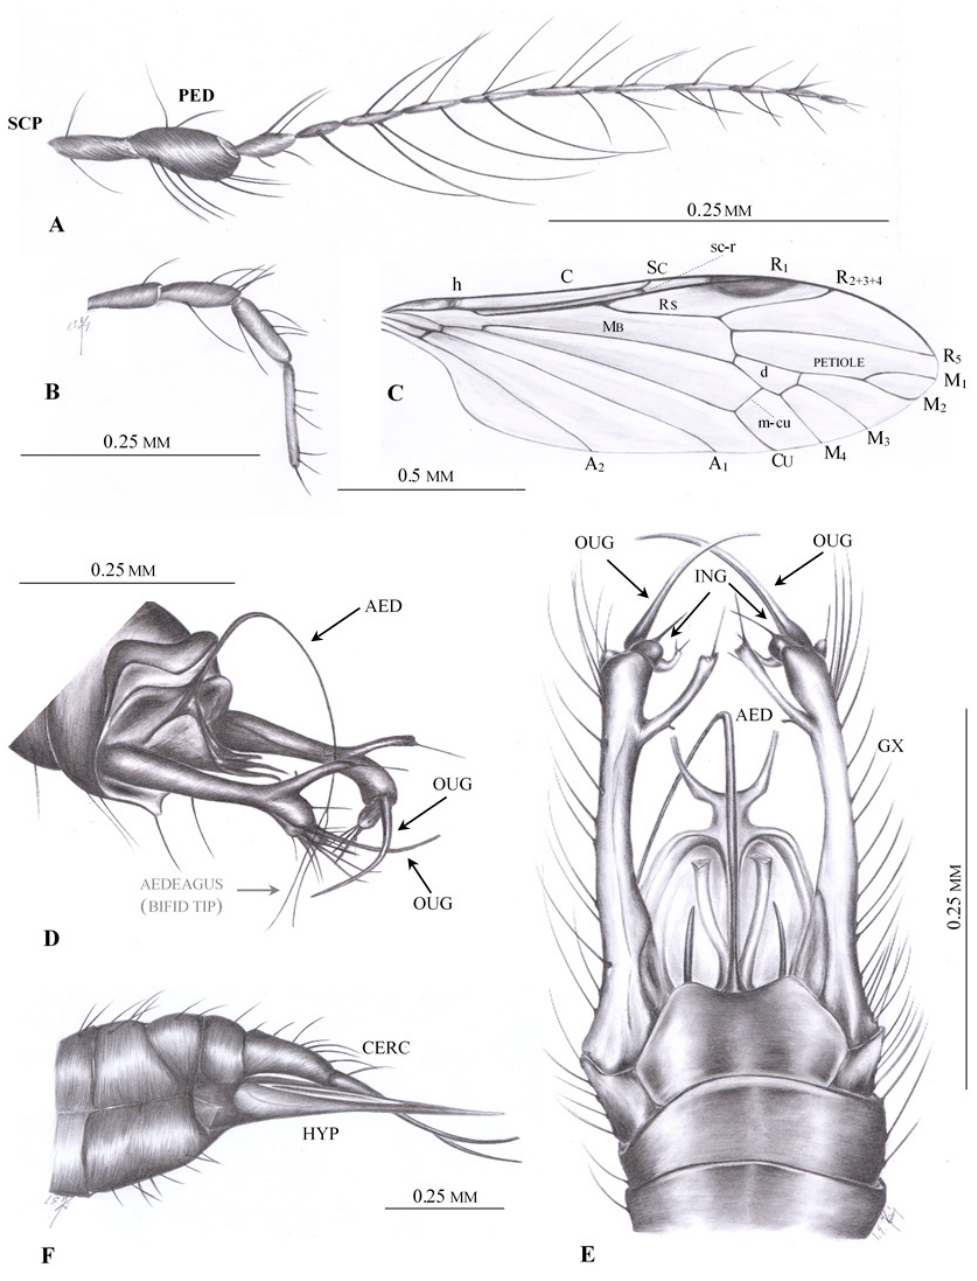
Figure 2. Drinosa prisca Podenas et Poinar, 2009 [13]. ( A ) No. MP/4068 (male) (ISEA PAS), antenna; ( B ) No. MP/4068 (male) (ISEA PAS), palpus; ( C ) No. MP/4068 (male) (ISEA PAS), wing venation; ( D ) No. MP/4068 (male) (ISEA PAS), hypopygium—lateral view, reconstruction; ( E ) No. MP/4022 (male) (ISEA PAS), hypopygium—dorsal view, reconstruction; ( F ) No. MP/4074 (female), ovipositor—lateral view. Abbreviation: scp—scape; ped—pedicel; ing—inner gonostylus; oug—outer gonostylus; gx—gonocoxite; cerc—cerci; hyp—hypogynal valvae.